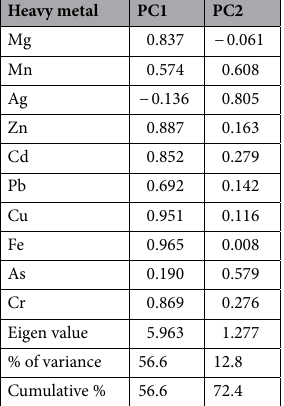
Table 8. Principal component analysis (PCA) of heavy metal in soil of automobile spare parts market.